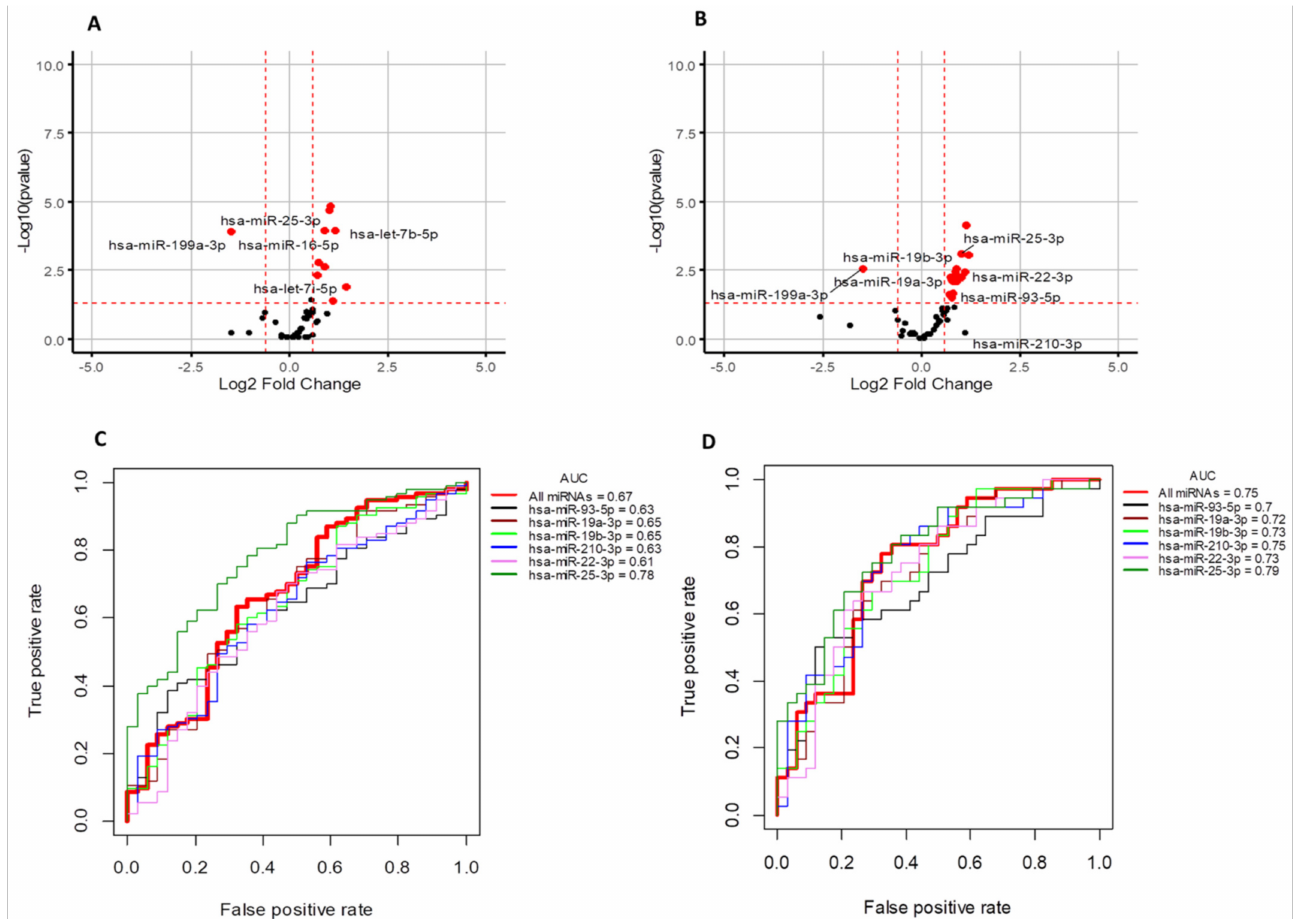
Figure 1. ( A , B ) Volcano plots showing the log2 fold difference between samples form healthy controls (n = 34) and breast cancer patients (n = 93) on the x-axis versus a measure of statistical significance (–log10 adjusted p -value) on the y-axis. Each point in the plot refers to a specific miRNA. The miRNAs that satisfied the criteria with adjusted p -value (BH) <0.05 are marked and highlighted as red marks in the figure. The miRNAs depicted in a black color did not have a significant adj-pvalue (BH). ( A ) Significantly regulated miRNAs in all breast tumors compared to control samples. ( B ) Significantly regulated miRNAs in TNBC compared to control samples. ( C , D ) AUC/ROC analysis (area under the curve/receiver operating characteristic curve) of significant differentially regulated miRNAs. ( C ) All breast cancers vs. control, ( D ) TNBC vs. control samples. AUC/ROC curves corresponding to individual miRNAs are plotted with different colors. The thick red in each plot represents the cumulative average expression of all miRNAs. See Table S2, Figure S3, and Supplementary Figure S4 for complementary